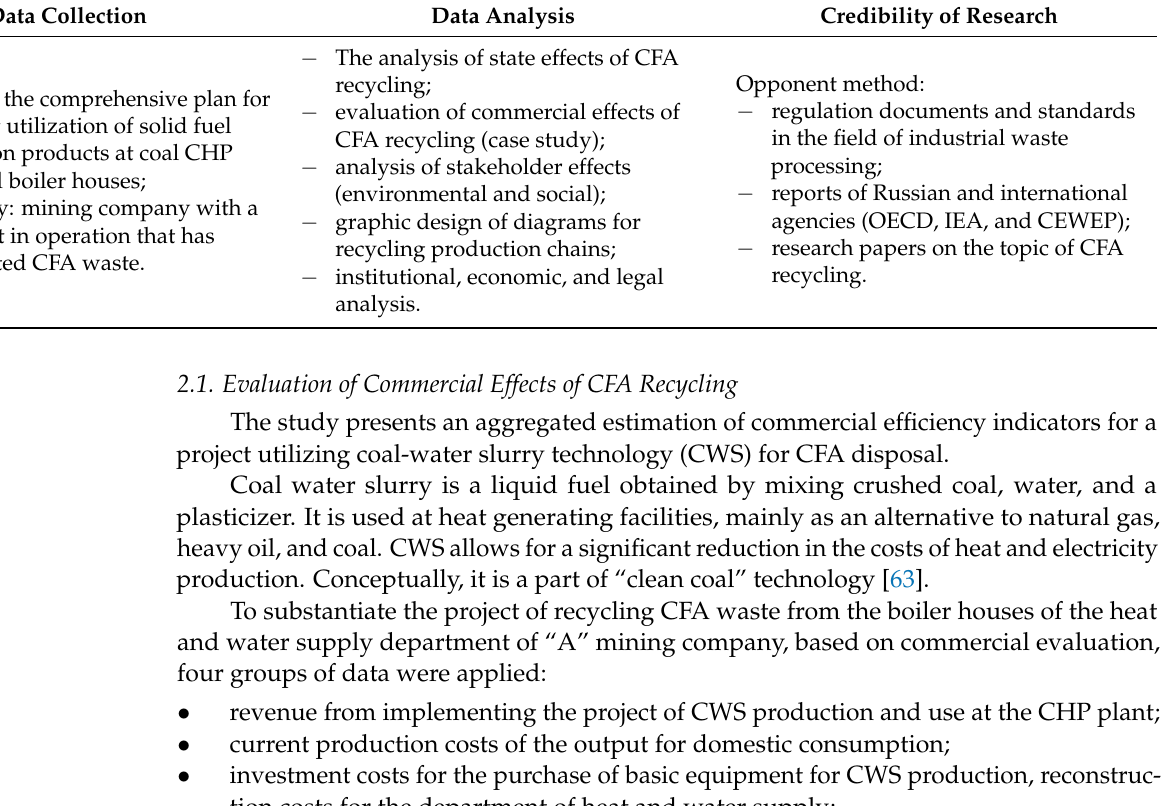
Table 1. Research design. Source: designed by the authors. Data